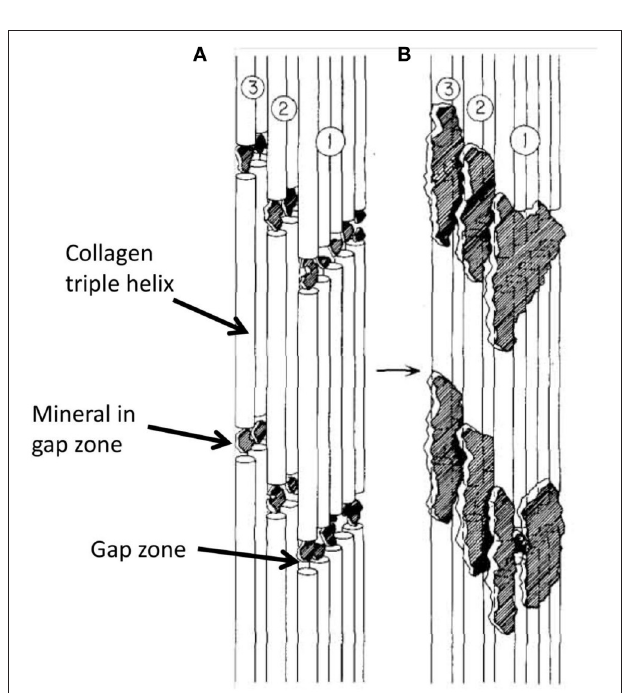
FIGURE 6 | TEM view of ion milled section of bovine femur, with plane of section oriented normal to the axis of the bone (cross section). Small-dashed arrow, hole marking site of collagen fibril; solid arrow, single mineral lamella viewed end-on; large-dash arrow, mineral lamella wrapping around fibril. Scale = 100 nm. From Schwarcz [53].